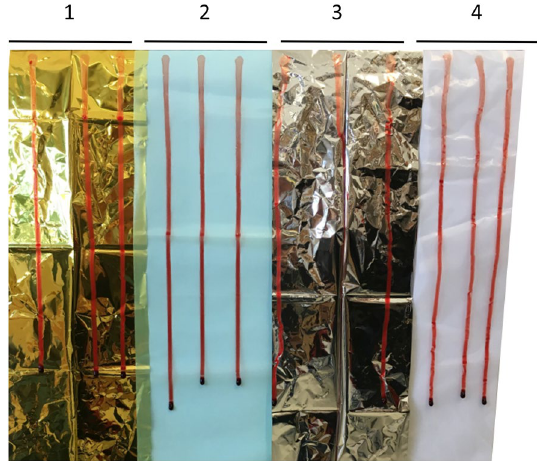
Figure 2. Blood stain: 10 min run-off pattern of twelve 100 µl drops on vertically arranged ( 1 ) polyethylene terephthalate (PET), ( 2 ) polyethylene (PE), ( 3 ) aluminum-coated polyethylene terephthalate (Al-PET) and ( 4 ) polyvinyl chloride (PVC)